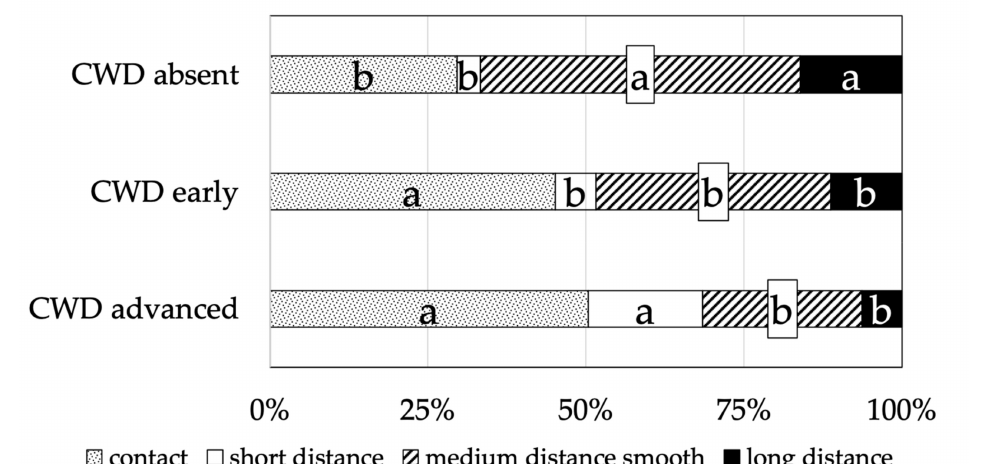
Figure 4. Mean relative abundance of taxa with di ff erent exploration types associated with Q. robur trees in the three study sites, characterized by the absence of coarse woody debris (CWD absent ) or coarse woody debris in early (CWD early ) or advanced (CWD advanced ) stages of wood decay. Within each tip classification, di ff erent letters indicate significant di ff erences between sites (Tukey´s contrast, p =